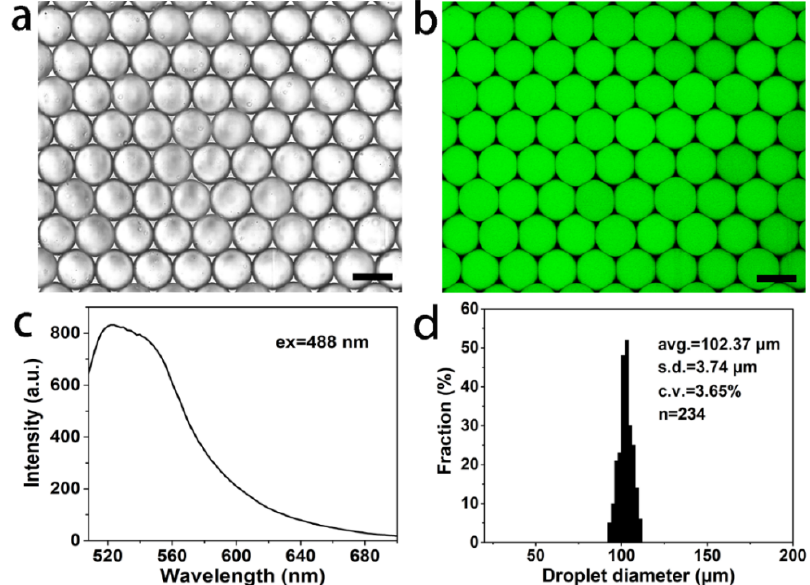
Figure 1. ( a ) Optical microscope image of the autofluorescent BSA hydrogel microspheres; ( b ) fluorescence microscope image of the autofluorescent BSA hydrogel microspheres (excited at 488 nm). All scale bars are 100 μ m; ( c ) photoluminescence emission spectra of the autofluorescent BSA